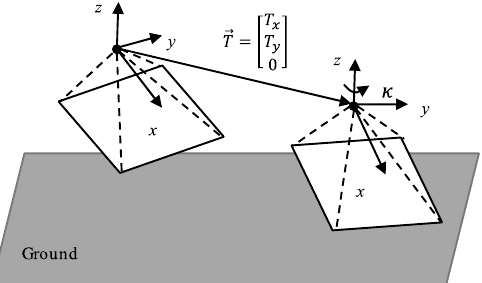
Figure 3. Stereo-images from a UAV platform equipped with a nadir-looking camera while moving at a constant flying height.